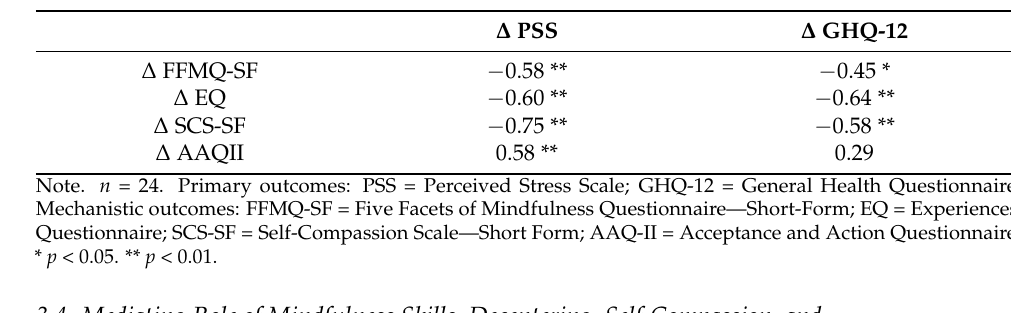
Table 4. Pearson’s correlations for change scores among primary and mechanistic